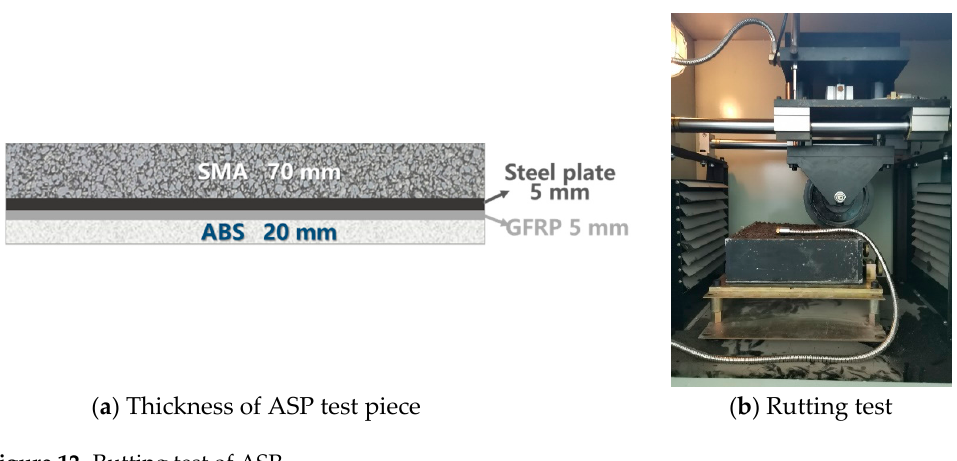
Figure 12. Rutting test of ASP.